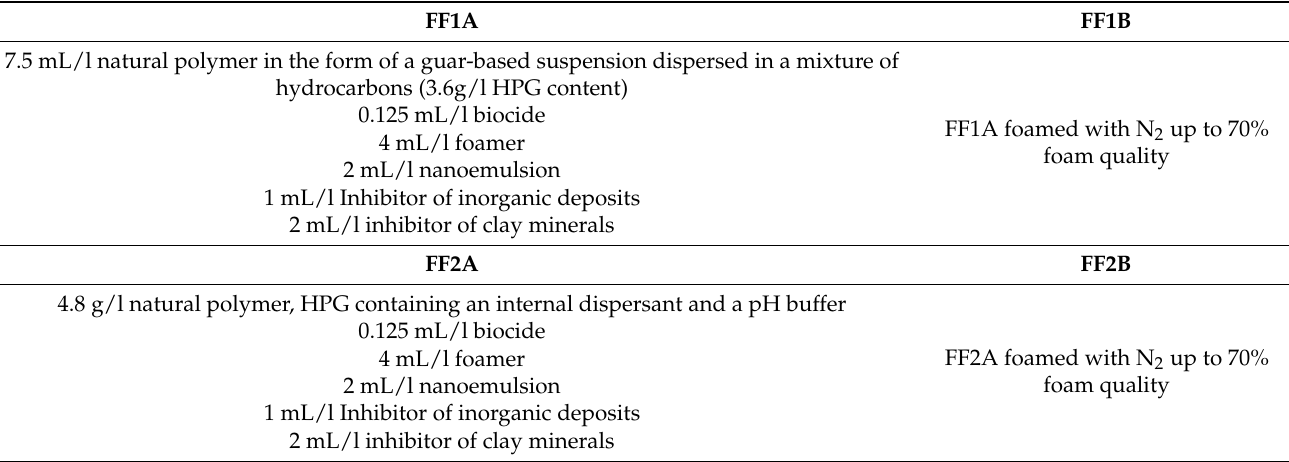
Table 2. Fracturing fluids components.